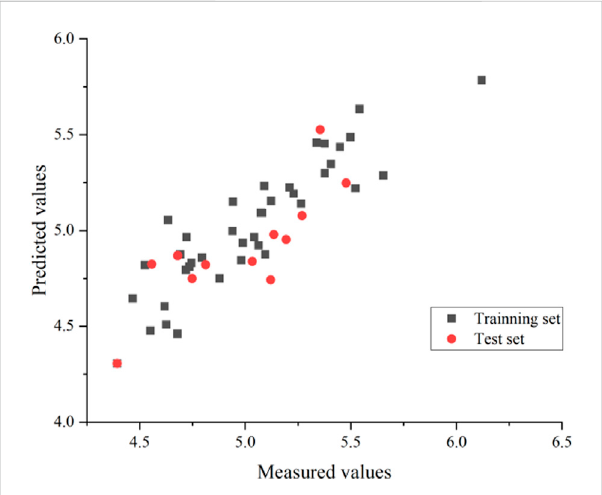
FIGURE 6 CoMSIA model predicted activity values compared with experimental